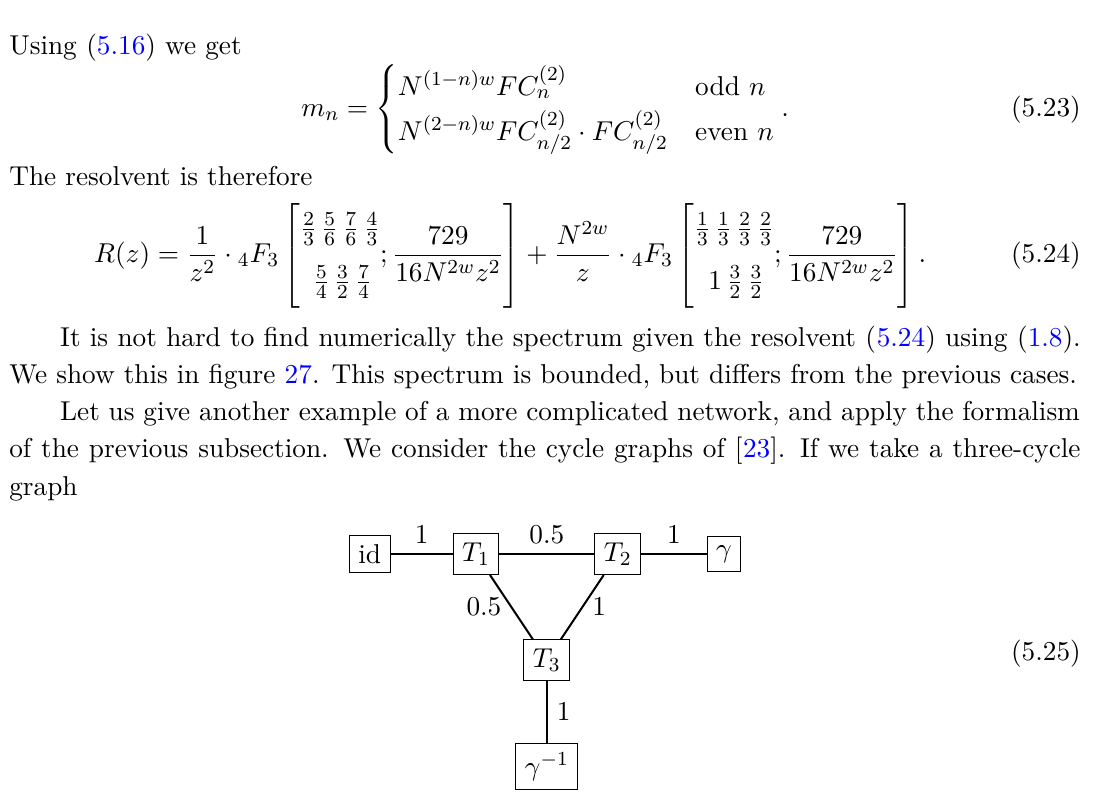
Figure 27 . A plot of the spectrum of the pure two-tensor network for N 2 w = 256 . We compare it to a simulation of this tensor network, averaging over 10 3 disorder